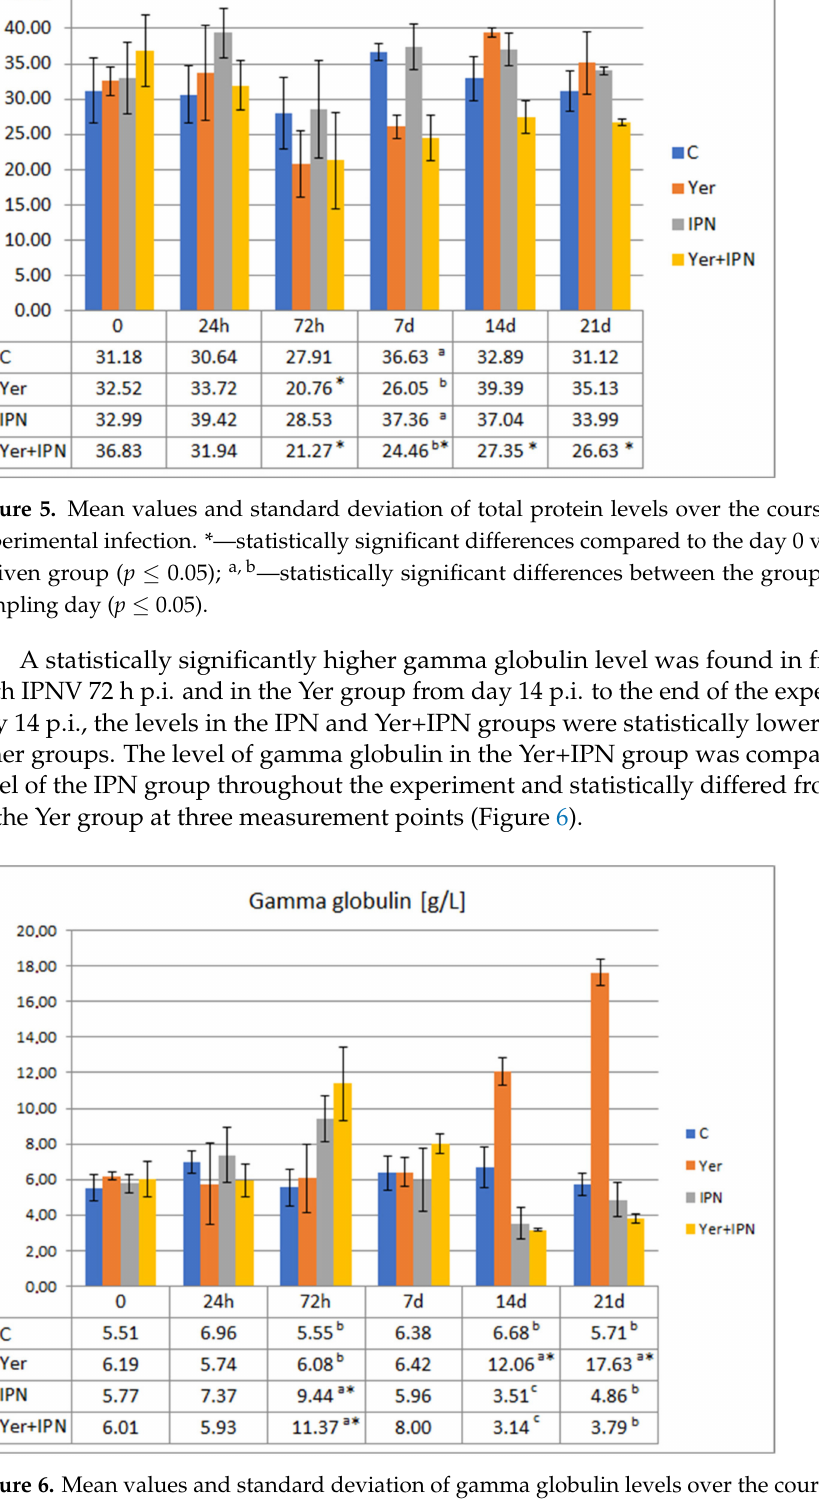
Figure 6. Mean values and standard deviation of gamma globulin levels over the course of the first experimental infection. *—statistically significant differences compared to the day 0 values within a given group ( p ≤ 0.05); a, b, c —statistically significant differences between the groups on a given sampling day ( p ≤